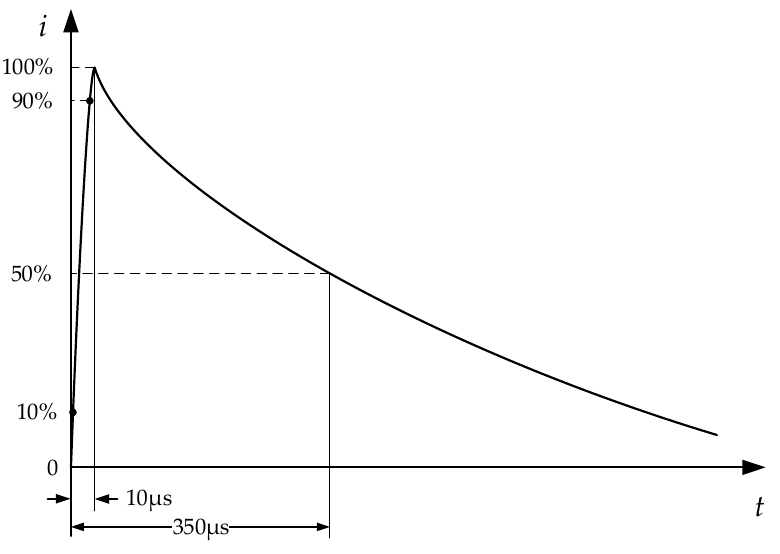
Figure 2. 10/350 lightning current waveform.